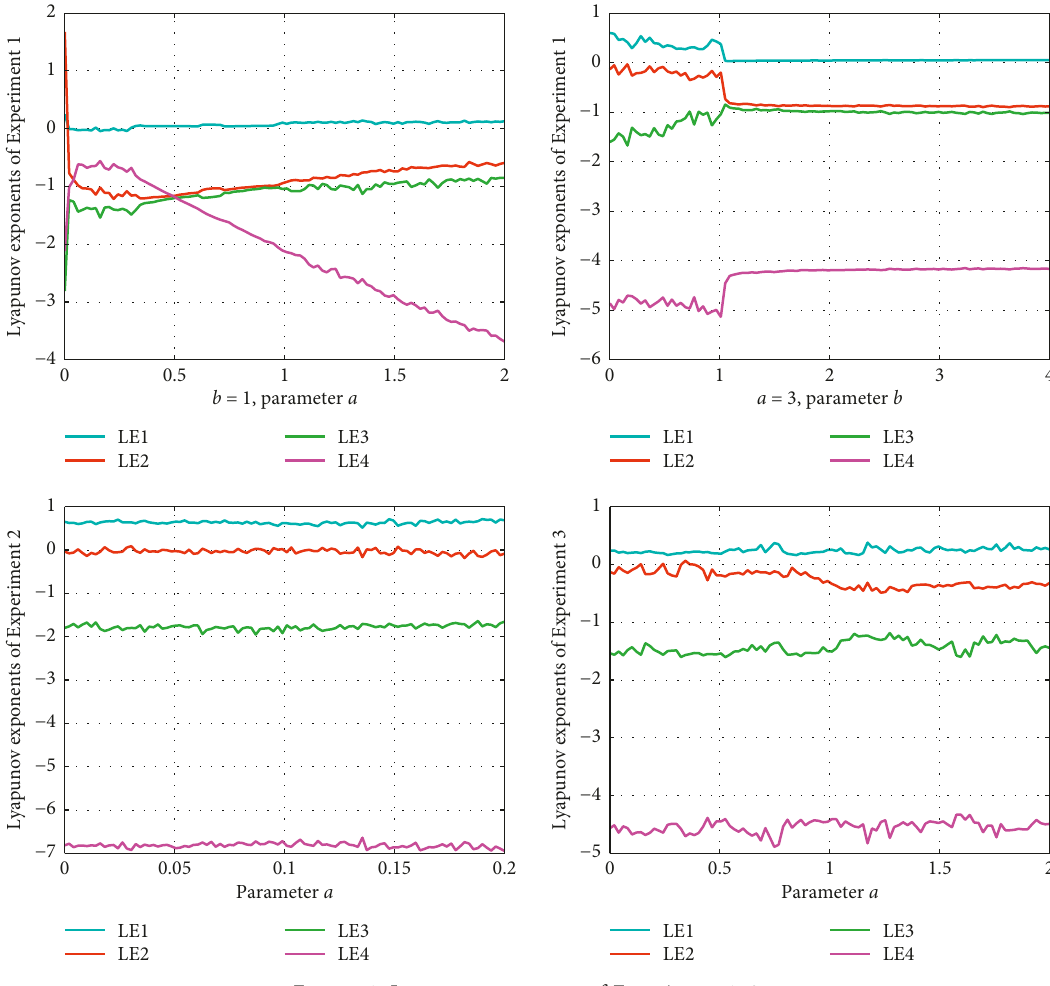
Figure 1: Lyapunov exponents of Experiment